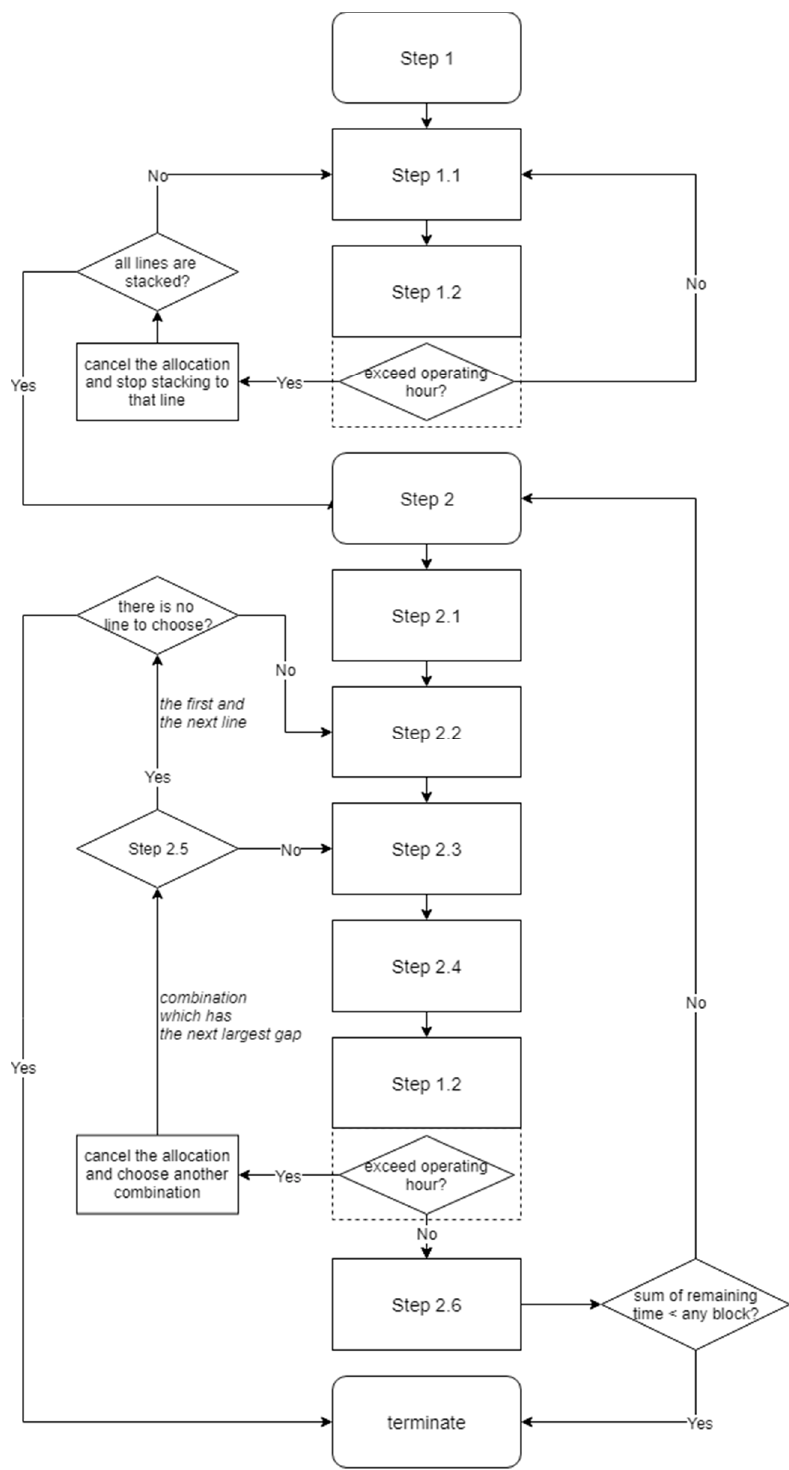
Figure 5. Overall flow of the proposed heuristic